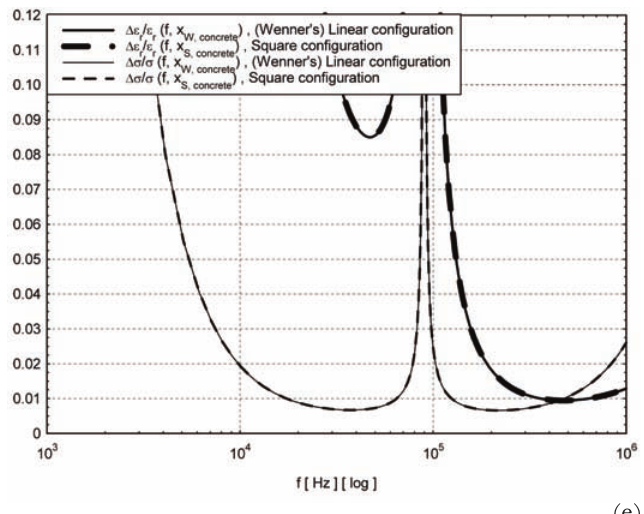
Figure 8e. Caption on previous